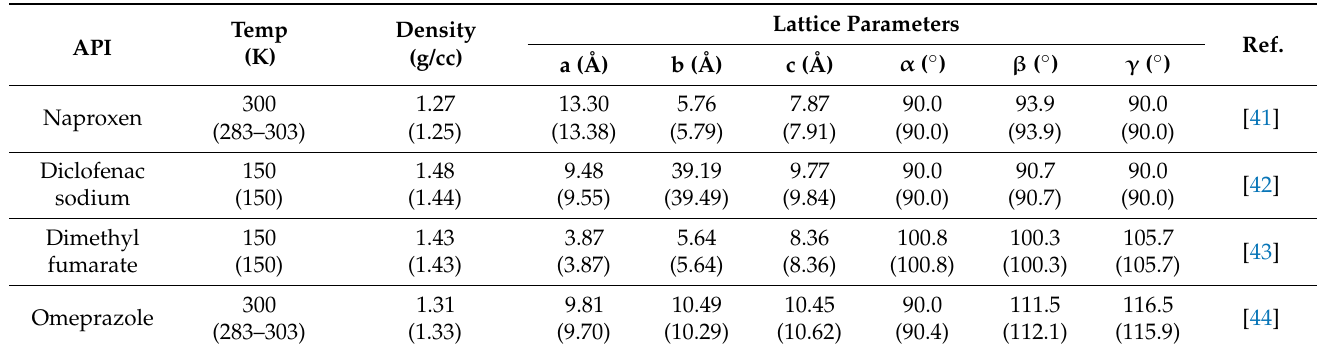
Table 2. Simulated densities and lattice parameters of drug crystals. The experimental values are mentioned in